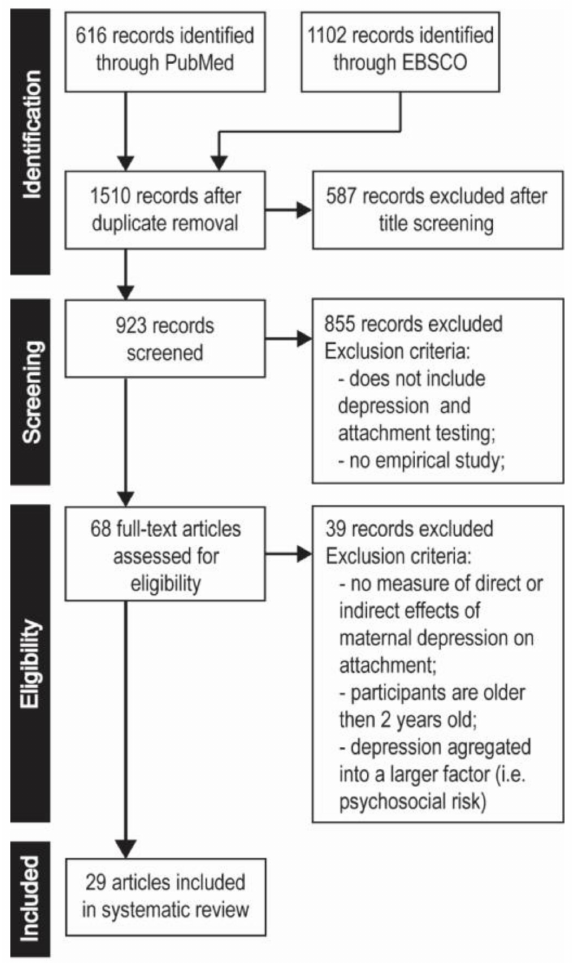
Figure 1. Flowchart of the search and systematic review